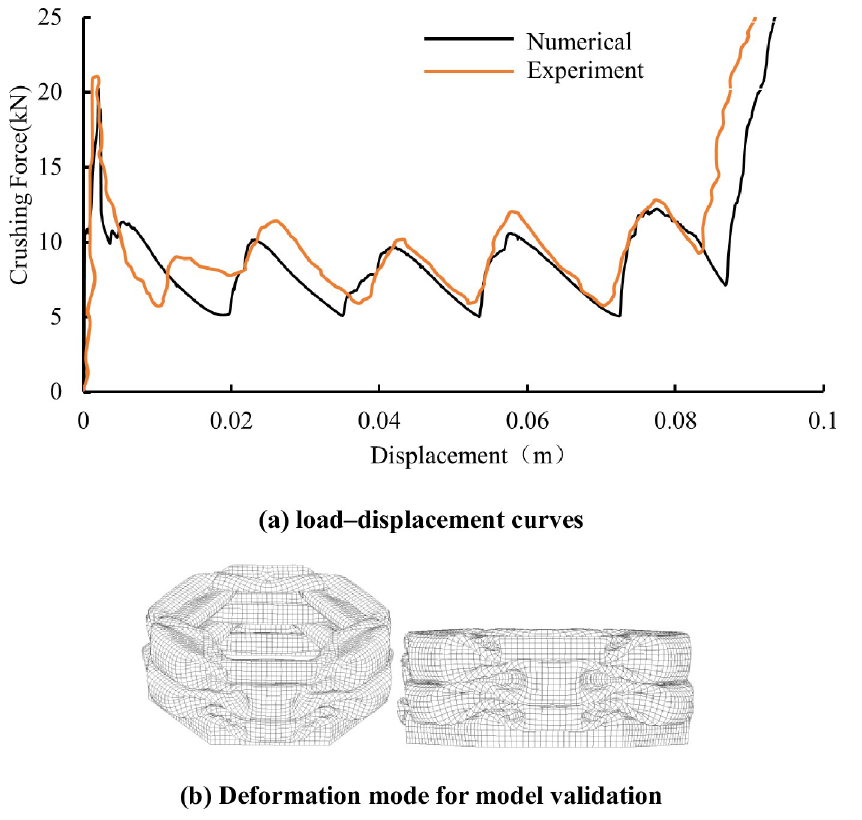
Fig 8. (a) Comparison between numerical and experimental. (b) Deformation mode for model validation